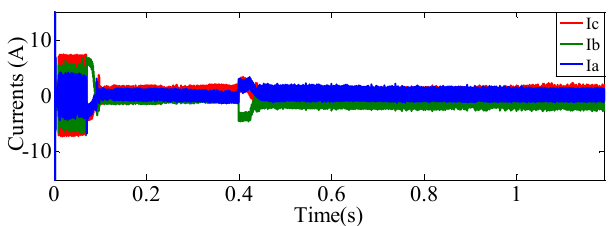
Fig. 8. The currents of PMLSM which uses the proposed sliding mode observer.